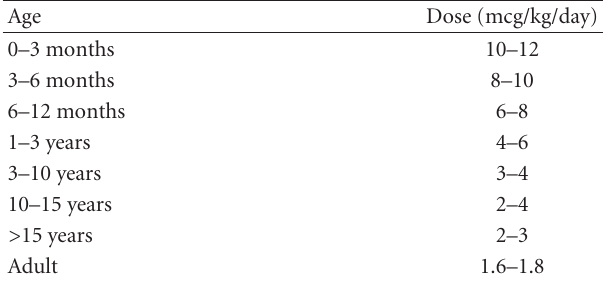
Table 2: Recommended levothyroxine (L-T 4 ) treatment